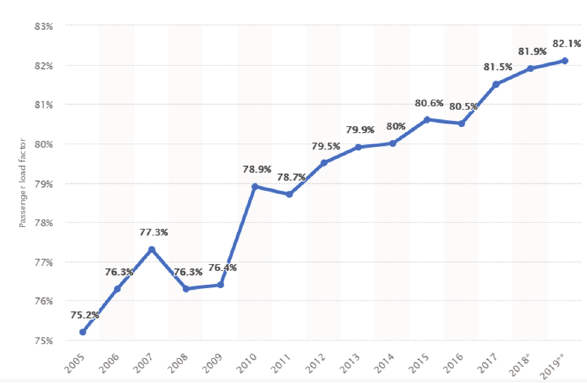
Fig. 1. Passenger Load Factor in commercial aircrafts worldwide since 2005 [13] Although, the trend is positive, it can be noticed, that there is still some room for